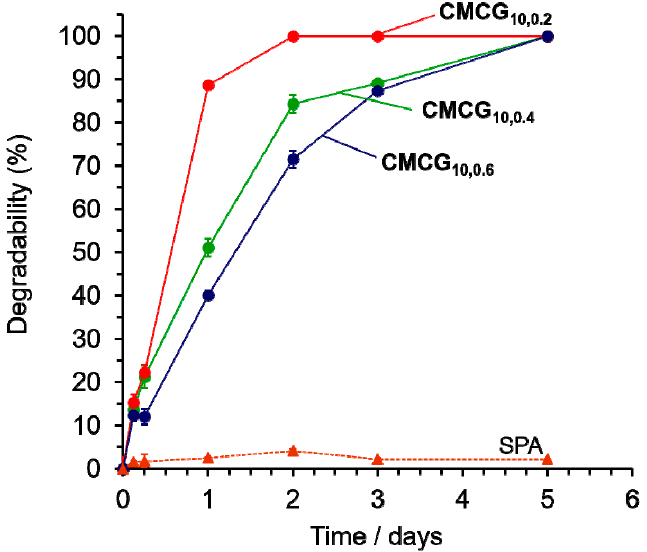
Figure 11. Time-dependency of the degradability of the CMCGs and SPA by cellulase in the 100 mM sodium acetate buffer (pH 5.0) at 313 K.